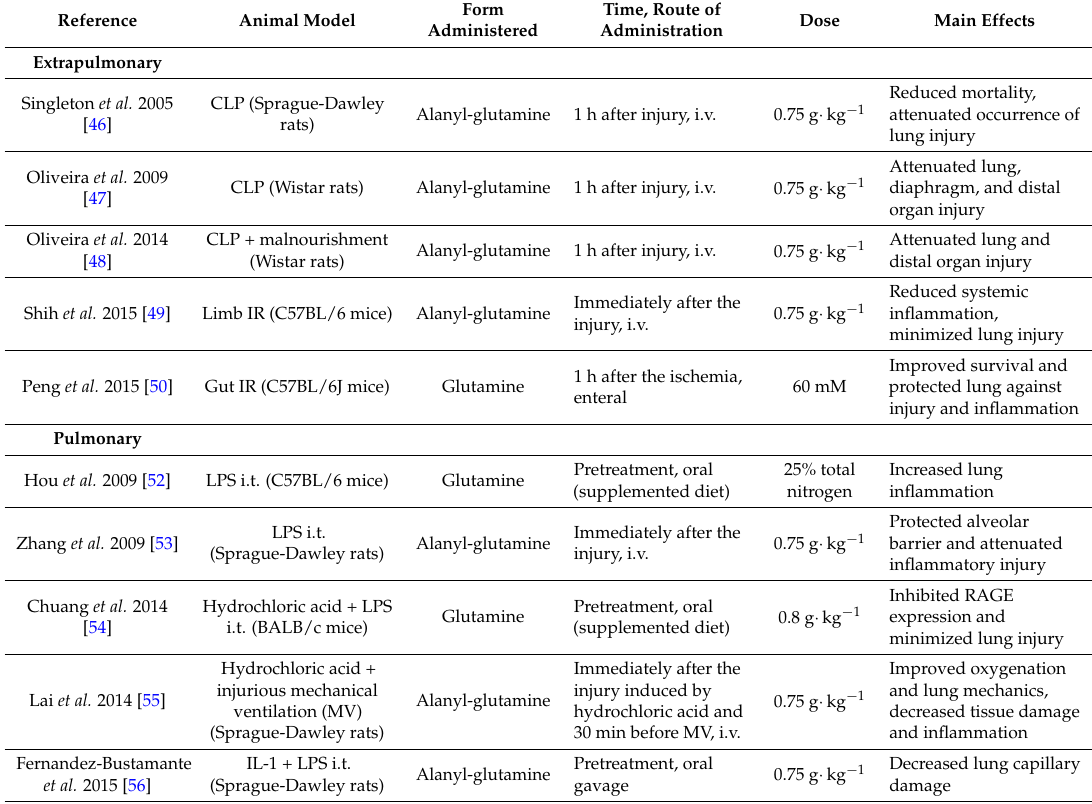
Table 1. Glutamine administration in ARDS models.